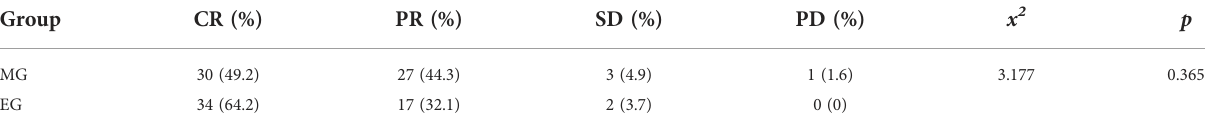
TABLE 4 Radiotherapy ef fi cacy and ef fi cacy rate. Group